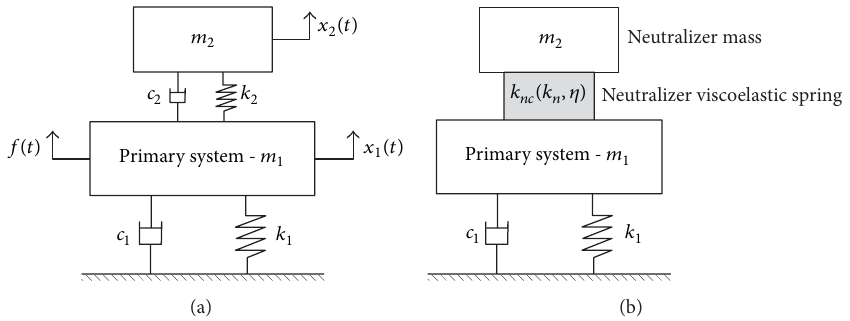
Figure 1: Schema of a (a) conventional (b) viscoelastic dynamic vibration neutralizer applied to a primary